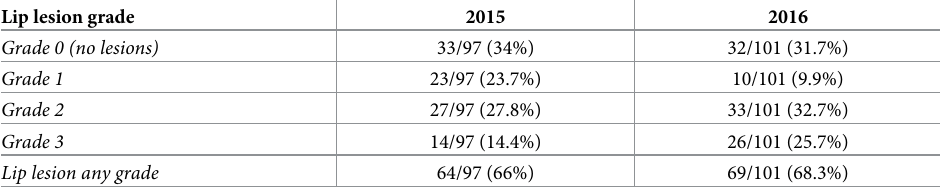
Table 1. Observed lip lesion prevalence in sun bears ( Helarctos malayanus ) at a Cambodian rescue centre in 2015 and 2016, including severity